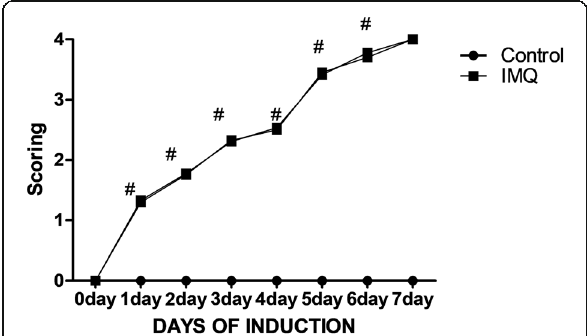
Fig. 1 Psoriasis Induced Graph